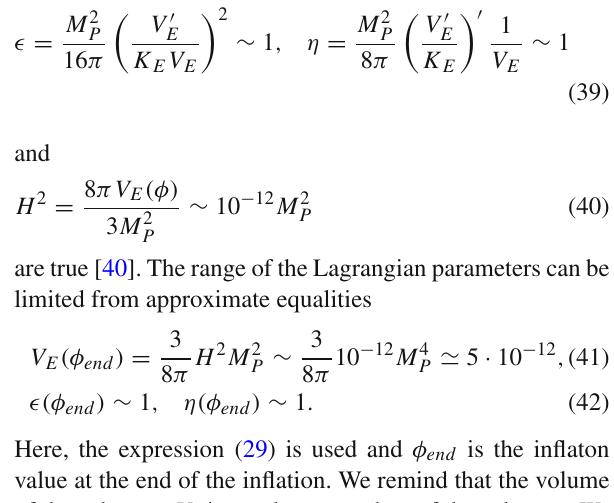
It is known that the inflation is finished when equality